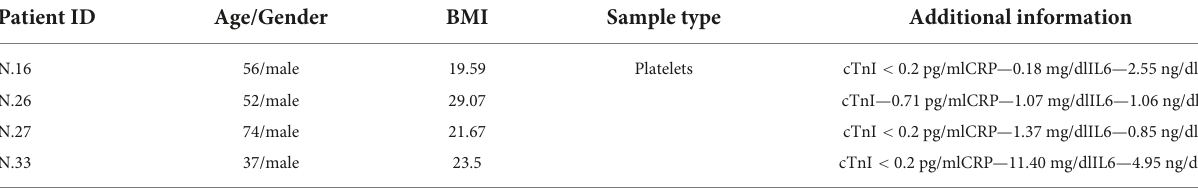
TABLE 1 Baseline characteristics of FAMI (cases) patients derived from GSE24591 dataset (10).